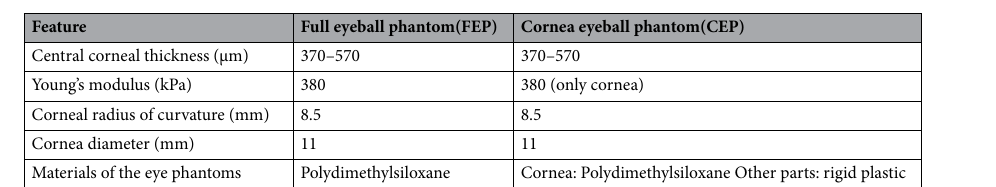
Table 2. The features of the two types of eye